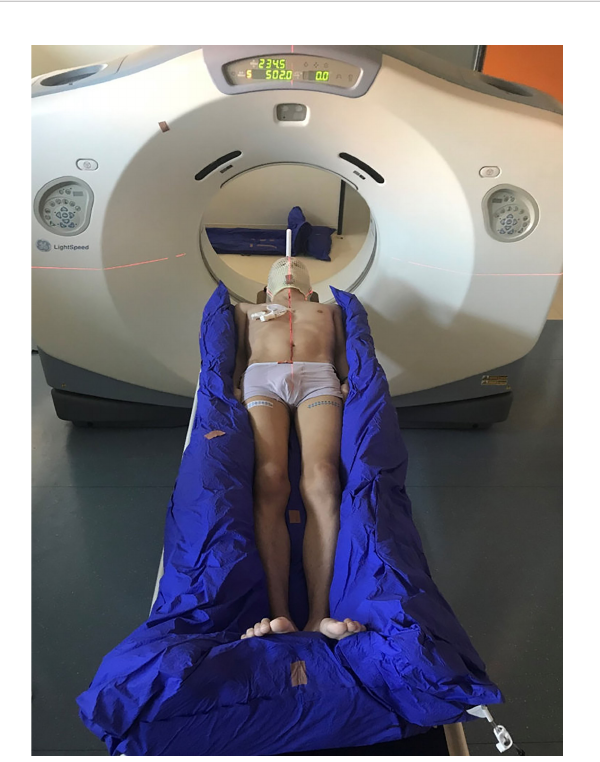
FIGURE 1 | CT simulation using a vacuum bag for body and extremity fi xation and a thermoplastic mask for head and neck fi